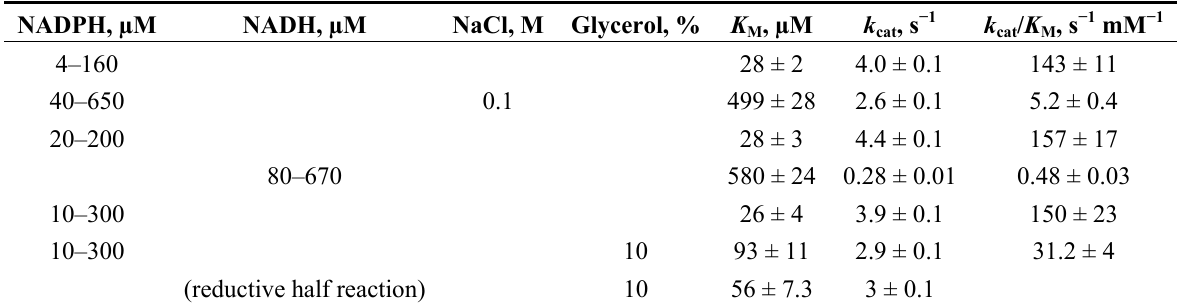
Table 2. Summary of the kinetic properties of the NADPH oxidase reaction of human MICAL-MO. Assays were carried out at 25 °C in the presence of the indicated NAD(P)H concentration ranges and additions in 20 mM Hepes/KOH buffer, pH 7.0. The last line for NADPH [86] and k calculated from an anaerobic reports the apparent K d red stopped-flow experiment in which MICAL-MO was reacted with varying concentrations of NADPH. Data are from